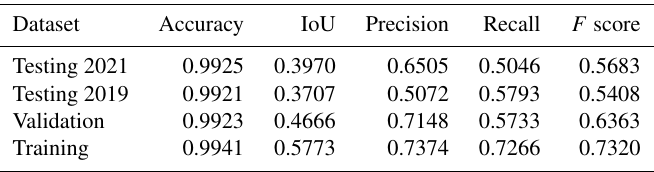
Table 4. Performance metrics for the green roof identification method, calculated based on area. For the full set of statistics for all folds, see the Appendix Table A4.